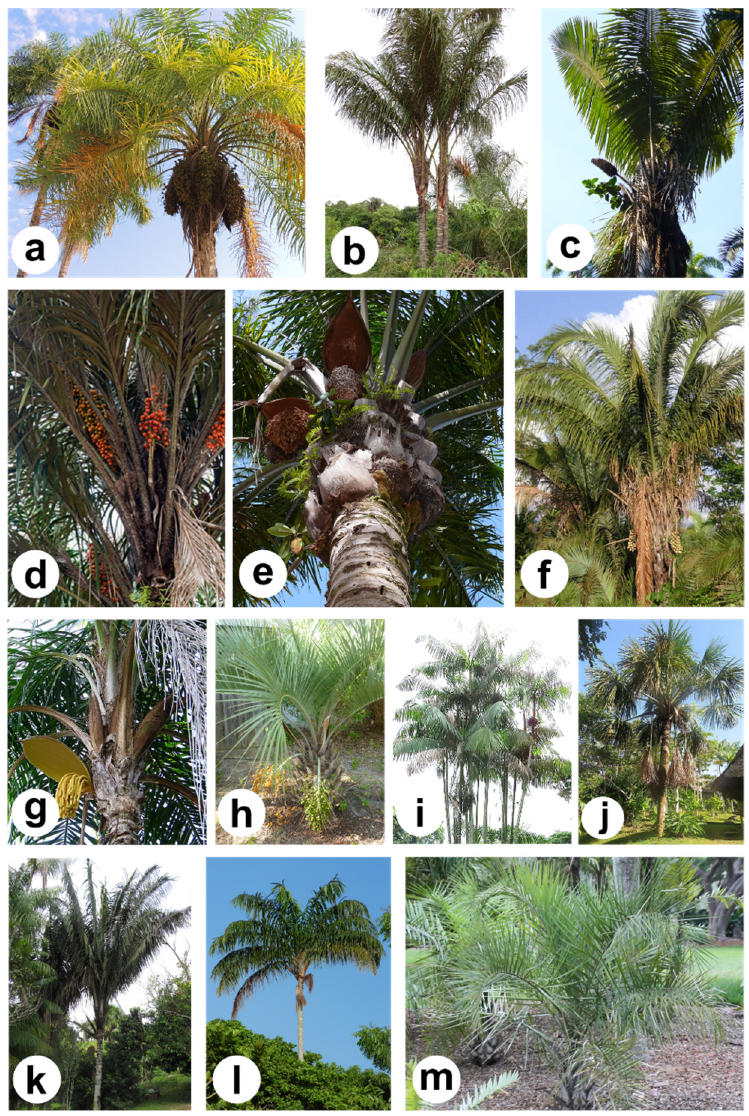
Figure 2. Arecaceae palm trees from Brazilian biodiversity: ( a ) Acrocomia aculeata , ( b ) Astrocaryum aculeatum , ( c ) Astrocaryum murumuru , ( d ) Astrocaryum vulgare , ( e ) Attalea maripa , ( f ) Attalea speciosa , ( g ) Bactris gasipaes , ( h ) Butia spp., ( i ) Euterpe oleracea , ( j ) Mauritia flexuosa , ( k ) Oenocarpus bataua , ( l )